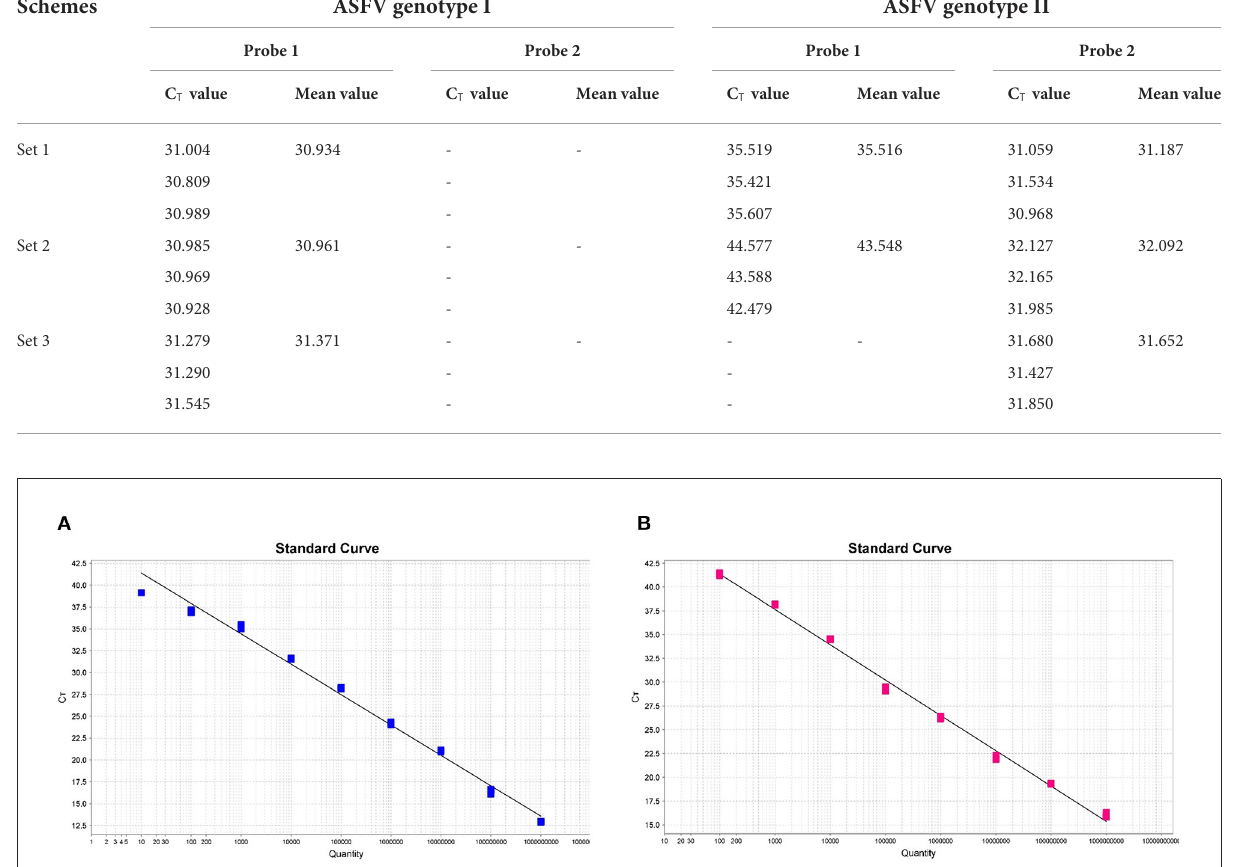
FIGURE2 The standard curves of the dual fluorescent quantitative PCR for ASFV genotype I (A) and II (B) in Chinese epidemic strains. Based on the mean of Ct values against log10 of 10-fold serial dilutions of the synthesized plasmids pUC57-ASFV-B646L-T1 and pUC57-ASFV-B646L-T2.